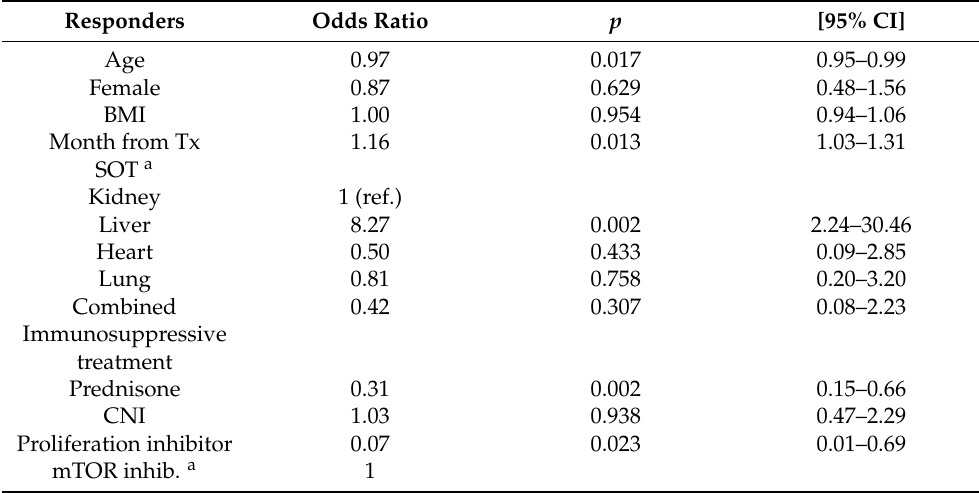
Table 2. Association between patient characteristics and immunosuppression following the third dose of a SARS-CoV-2 mRNA vaccine among solid organ transplant